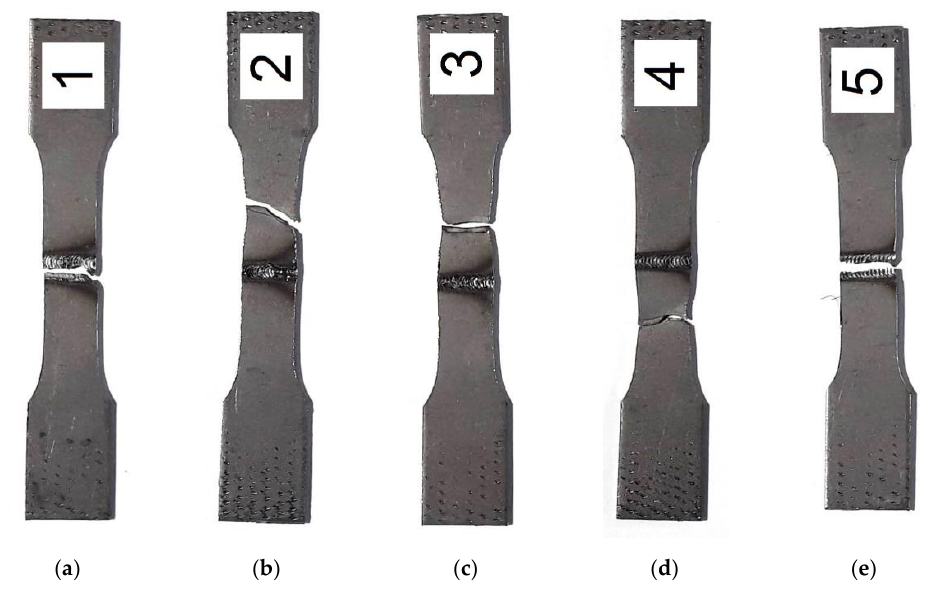
Figure 4. Second step—tensile test until the fracture: ( a ) Sample 1, ( b ) Sample 2, ( c ) Sample 3, ( d ) Sample 4, ( e ) Sample 5. The parameters corresponding to each sample are given in Table